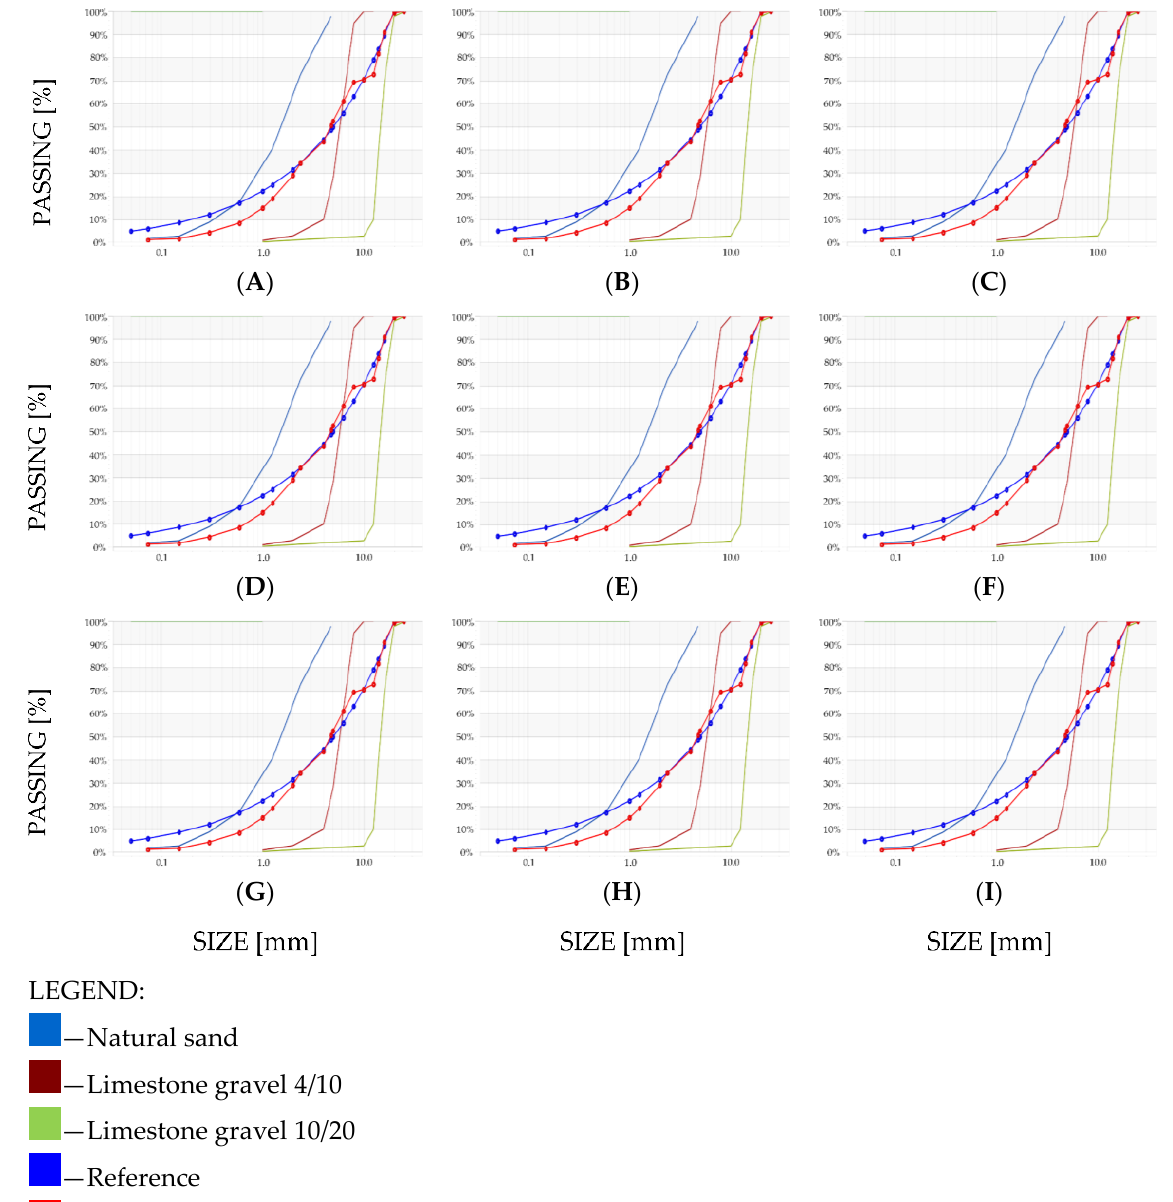
Figure A6. Gradings and fitting curves for Recipe #3—standard mix with superplasticizer (polycarboxylate ether), retarder (phosphate) and air entrainer (tensides) designed according to the Fuller Method: ( A ) 10 MPa; ( B ) 15 MPa; ( C ) 20 MPa;